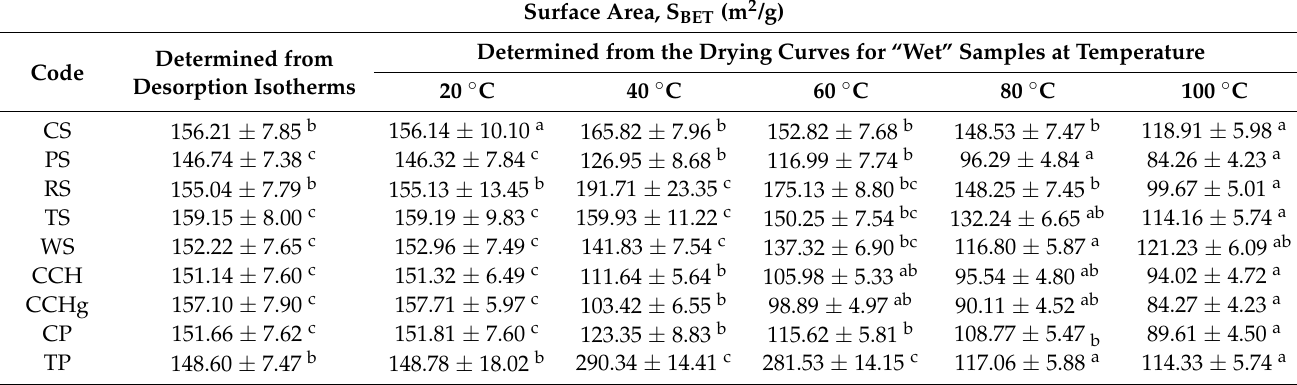
Table 4. Comparison of specific surface area determined from desorption isotherms vs. drying